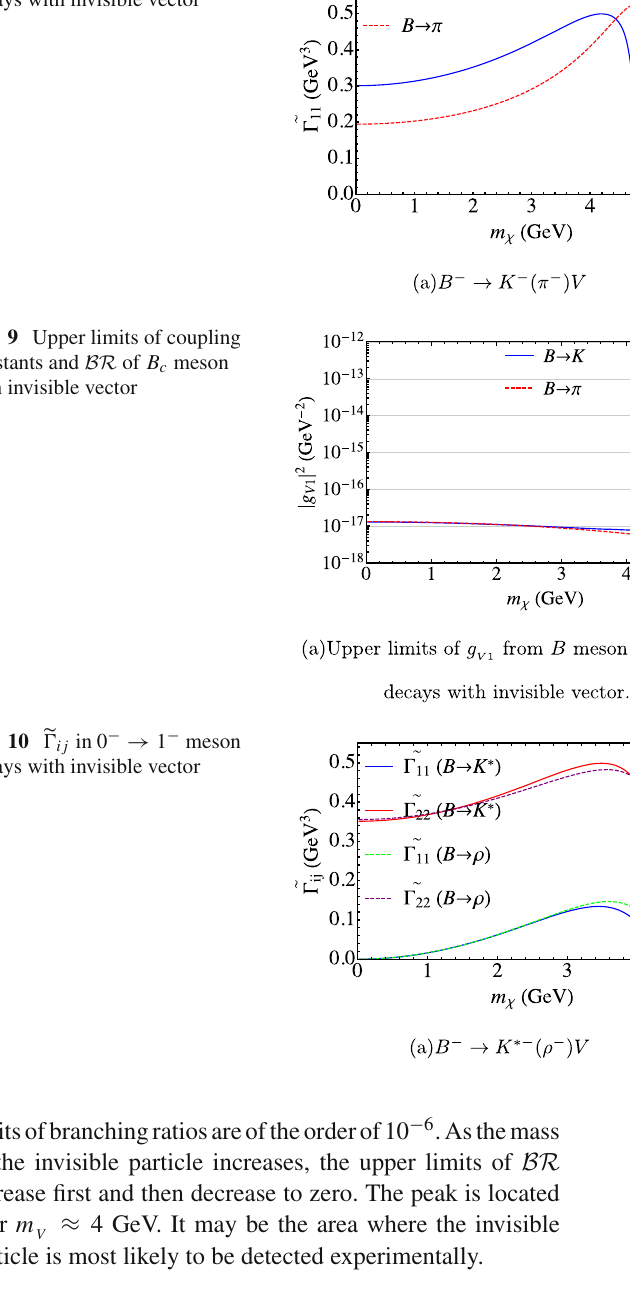
Fig. 8 (cid:6) (cid:8) 11 in 0 − → 0 − meson decays with invisible vector